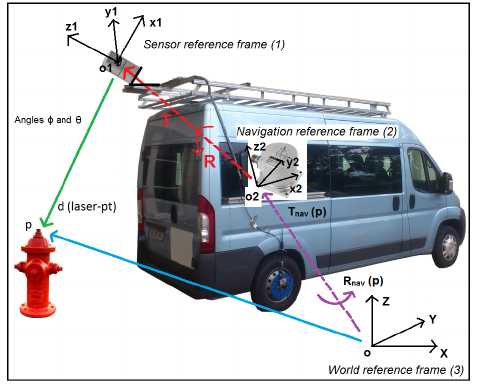
Figure 1. Geo-referencement of the